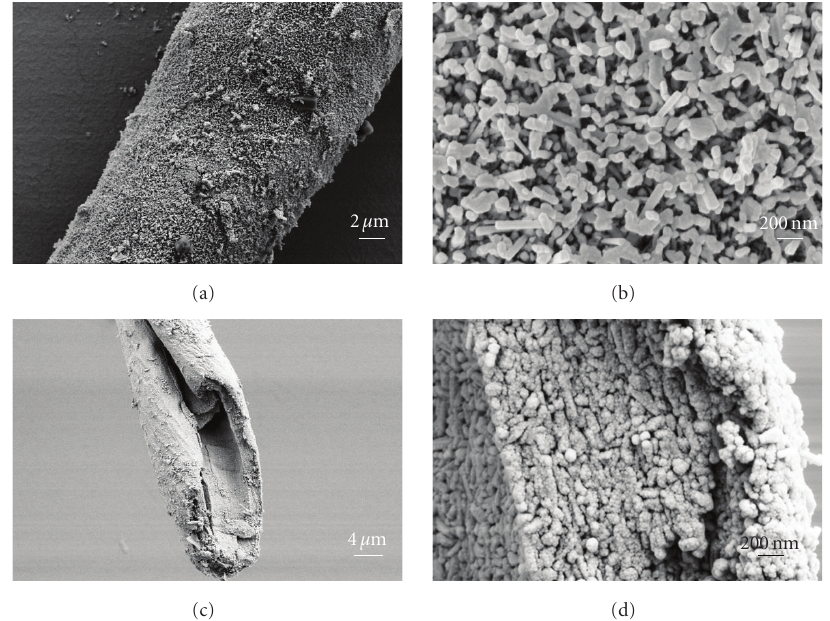
Figure 3: SEM images of sample 2 (a), (b) and sample 3 (c), (d).